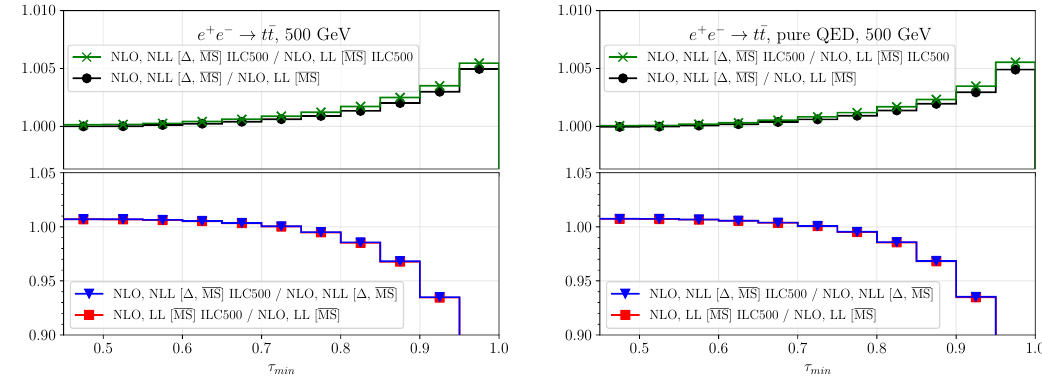
Figure 11 . As in figure 10, for t ¯ t production in the full SM (left panel) and in QED (right panel).